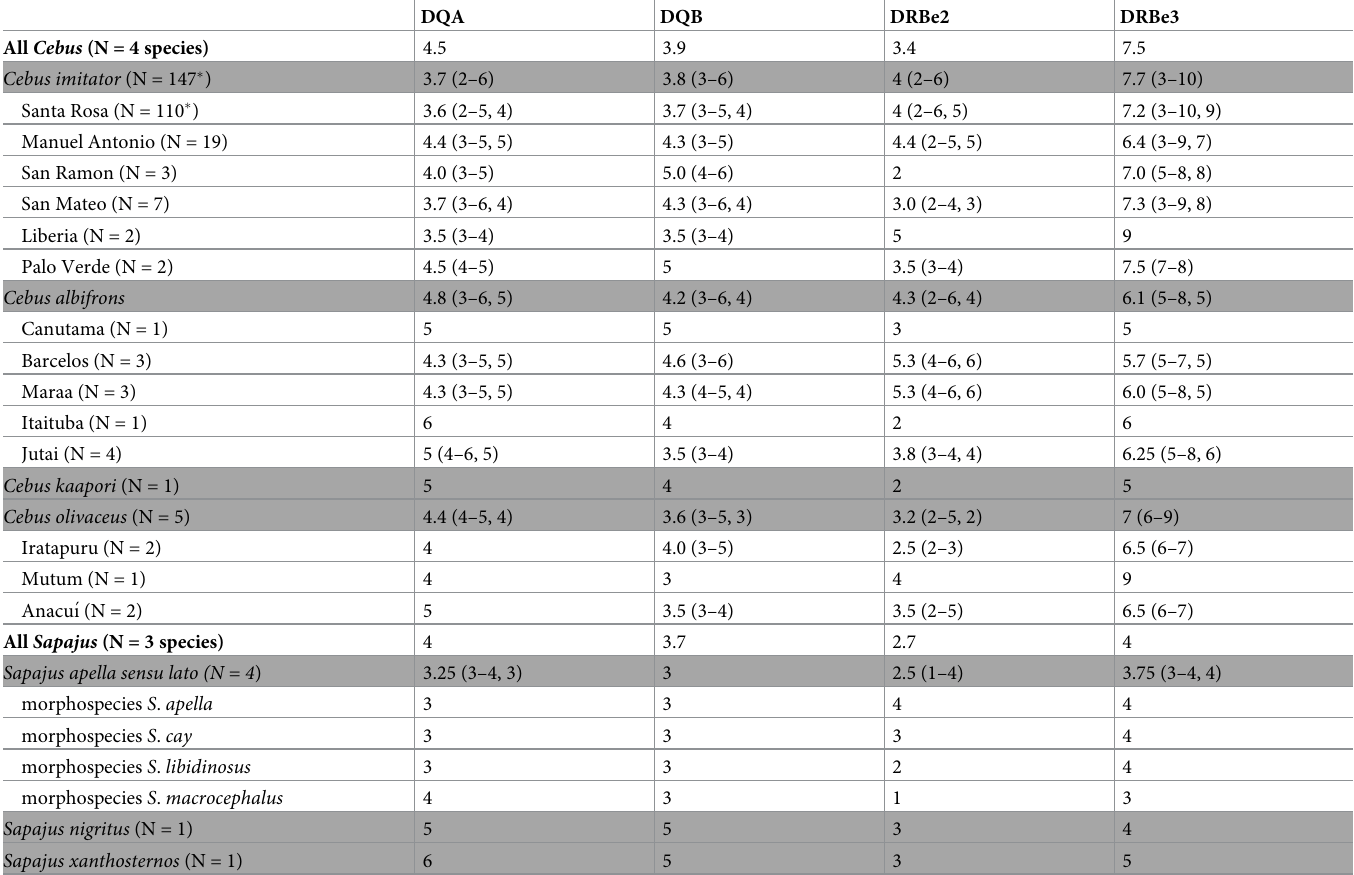
Table 4. Mean number of MHC alleles per individual, by population, species and genus.